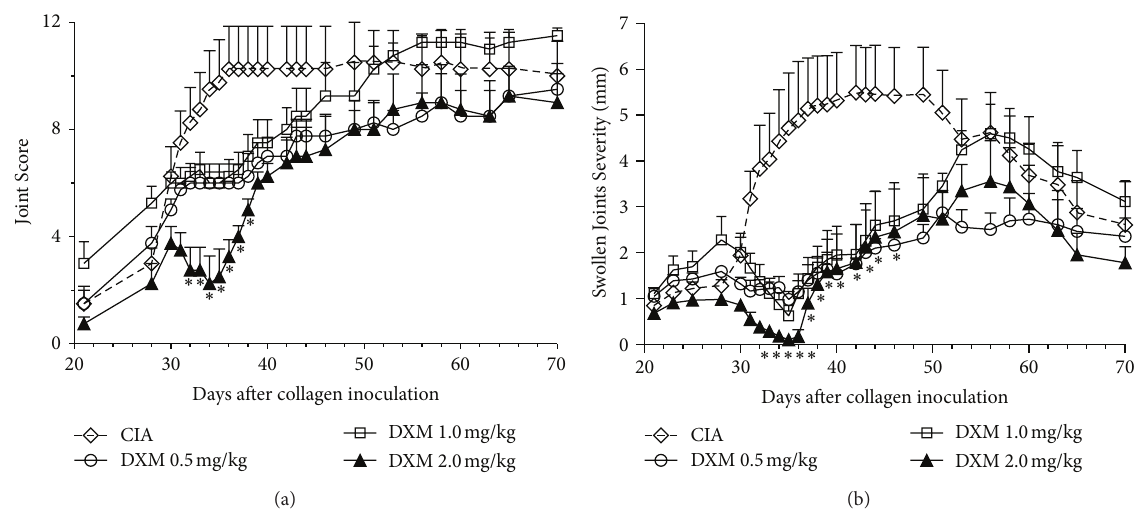
Figure 1: Dexamethasone (DXM) dosing for collagen-induced arthritis (CIA) inhibition. (a) Different doses of DXM (0.5, 1.0, and 2.0 mg/kg) were intraperitoneally administered to DBA1/lacJ mice from days 29 to day 34 after CIA induction. The mean Joint Score and the Swollen Joint Severity Score were determined until day 70. Data from a representative experiment of three experiments performed with 8–10 mice per group. ∗ 𝑃 < 0.001 , in DXM 2.0 mg/kg versus CIA